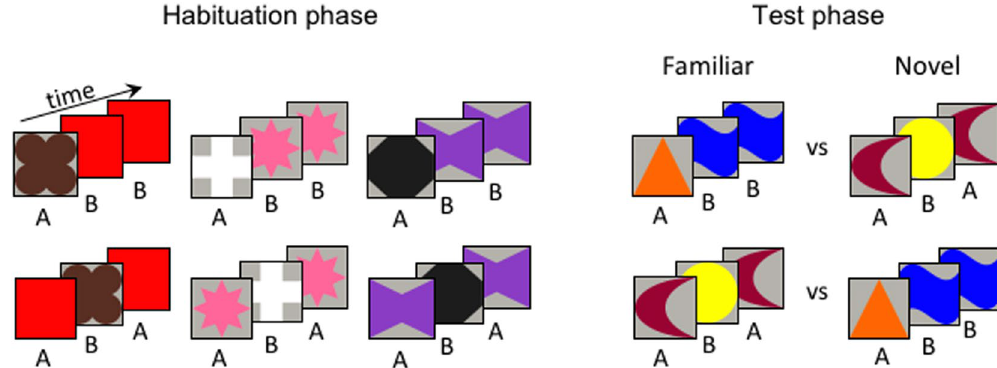
Figure 1. Examples of the stimuli used during the habituation and the test phases of Experiments 1 and 2. The shapes within each triplet were presented sequentially on the screen, from left to right in Experiment 1, and from right to left in Experiment 2. Half of the infants in each experiment were habituated to ABB rule-like sequences, whereas the other half were habituated to ABA rule-like